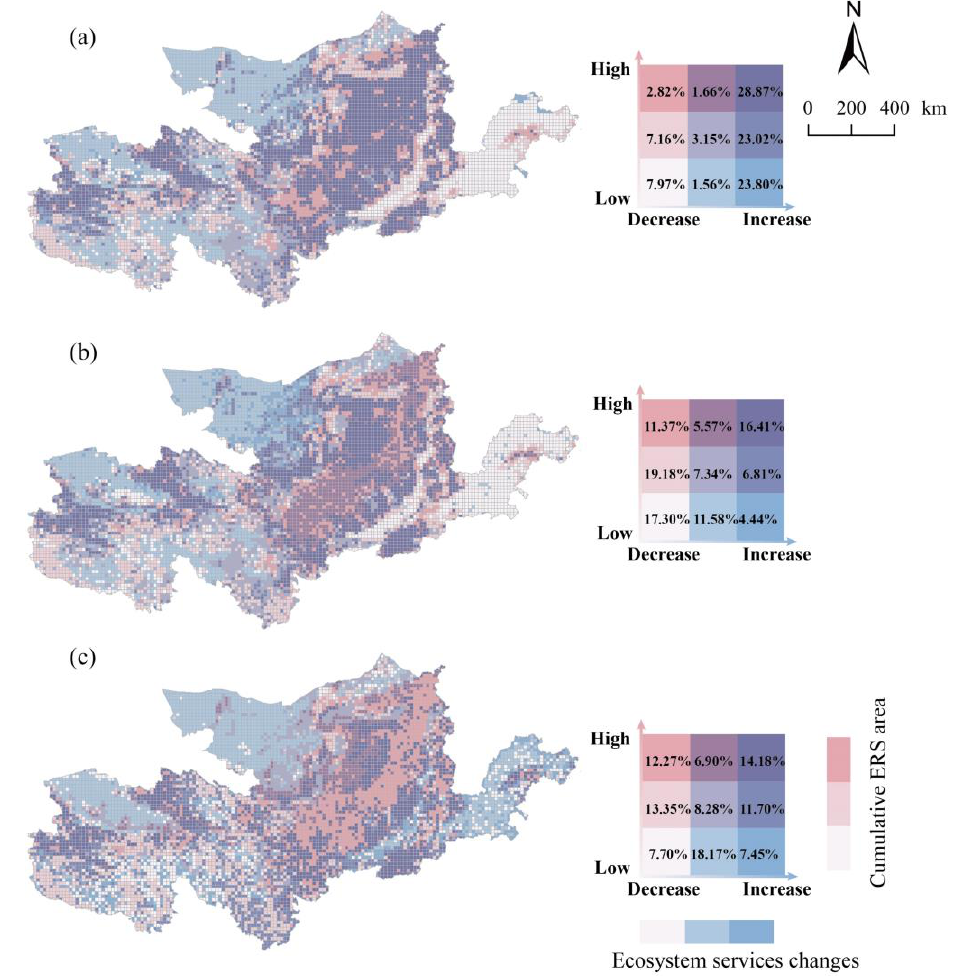
Figure 7. Overlaying the cumulative area of ERS on the changing values of ESs (( a ) habitat quality; ( b ) carbon storage; ( c ) soil conservation) from 1990 to 2015. The color red indicates the cumulative area of ERS, with darker shades representing larger accumulated areas within each grid. The color blue denotes the changing value of ESs from 1990 to 2015, with darker shades indicating more pronounced changes. The percentage in the legend is the proportion of the number of grids in the corresponding interval.